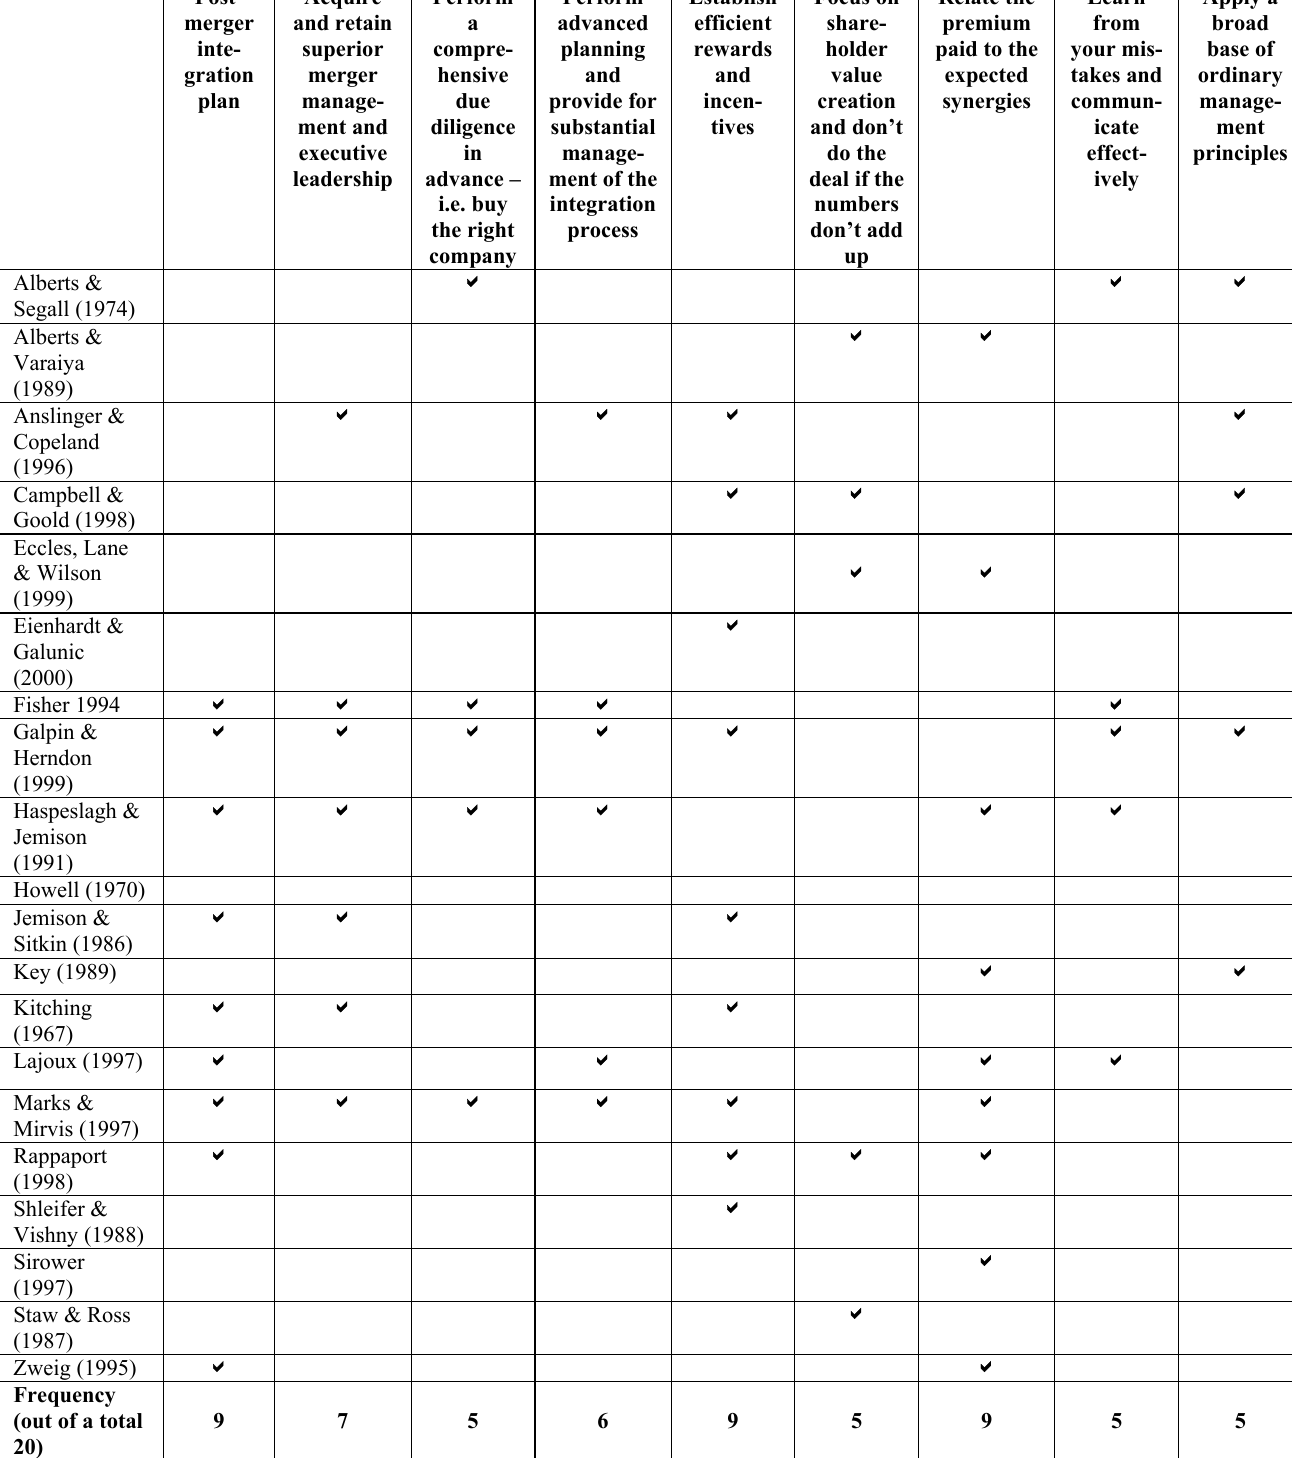
Table 3: Techniques for generating productive synergies Post-